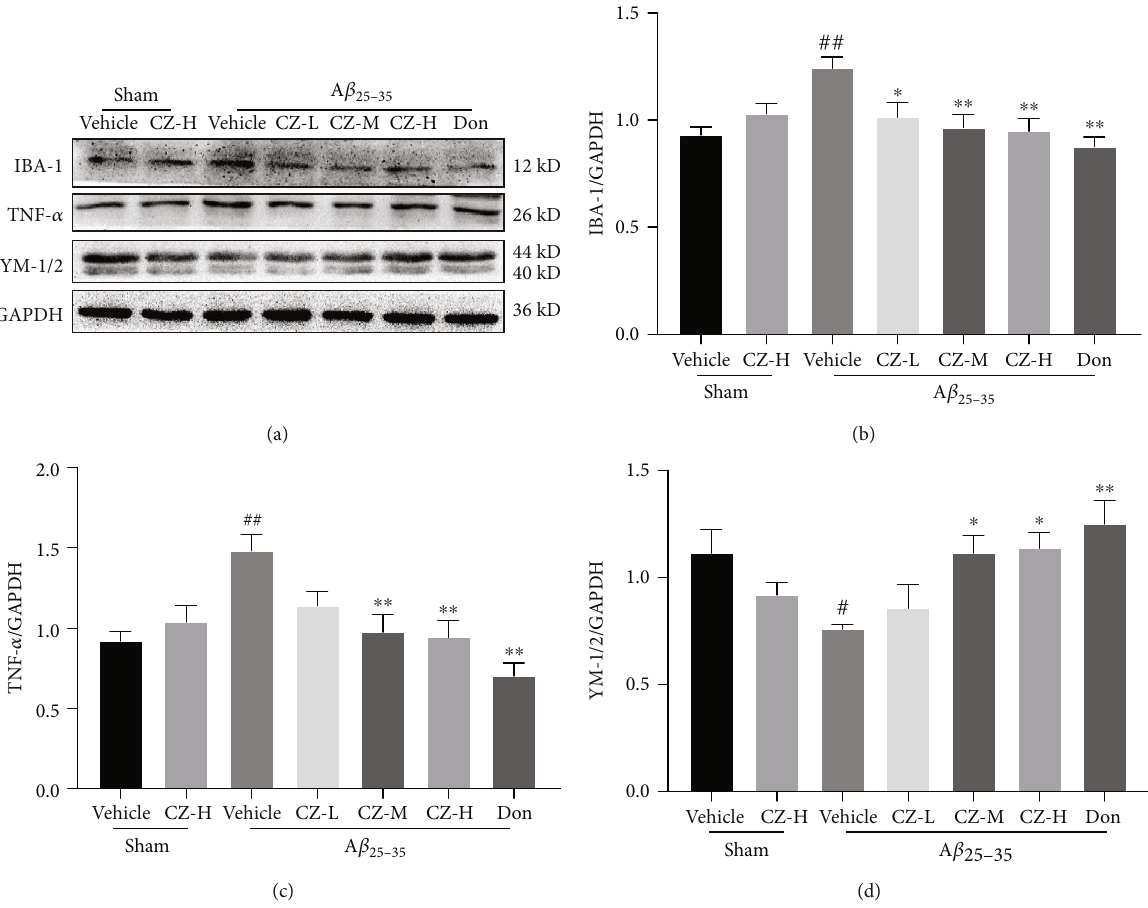
Figure 3: CZYH suppresses A β -induced proin fl ammatory microglial activation in the hippocampus of rats. (a) The antibody-reactive 25-35 band of IBA-1, TNF- α , and YM-1/2. (b – d) Quanti fi cation of (b) IBA-1, (c) TNF- α , and (d) YM-1/2 protein expression levels. Values are means ± SEM , n = 5 . # P < 0 : 05 and ## P < 0 : 01 vs. sham; ∗ P < 0 : 05 and ∗∗ P < 0 : 01 vs. A β 25-35